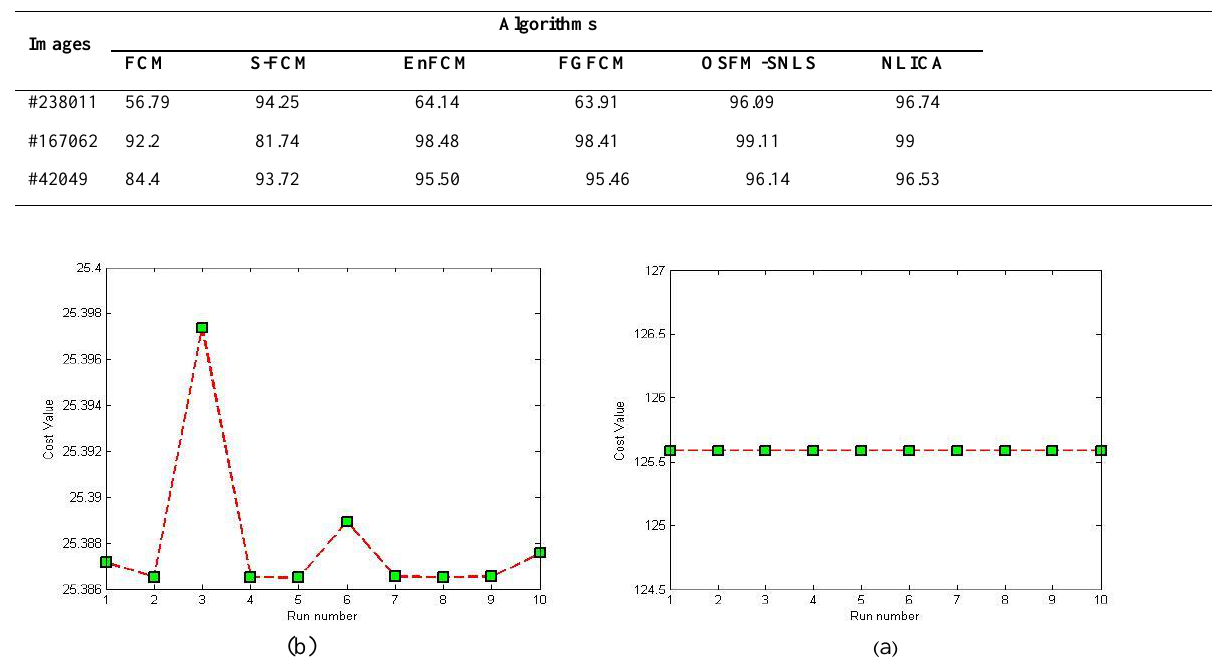
Table 4. Results of the natural test images’ segmentation using different algorithms (in terms of accuracy (percent)).